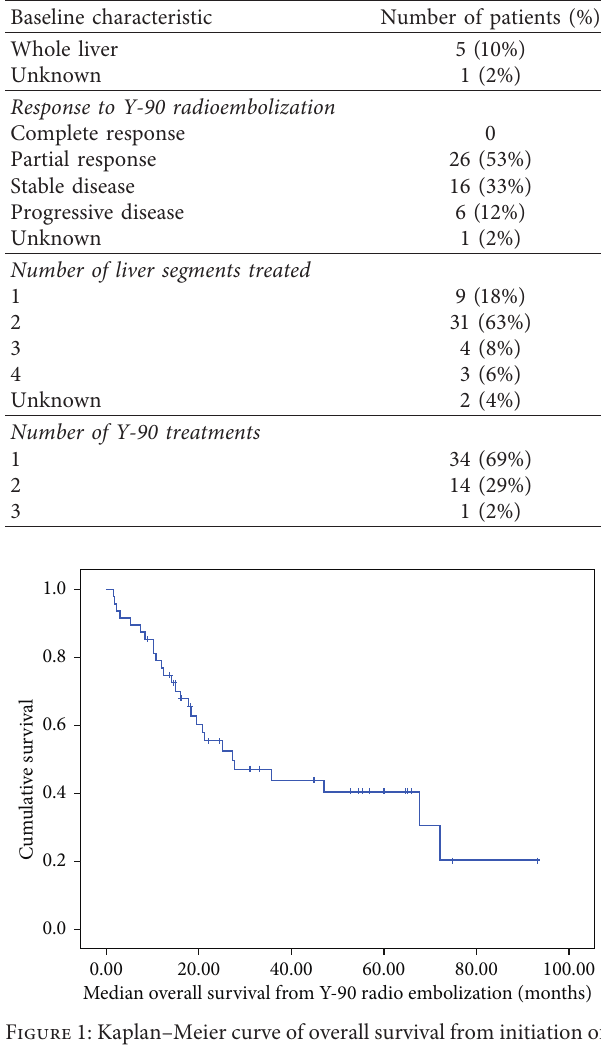
Table 1: Baseline demographic and clinicopathologic character- istics of patients with metastatic liver-dominant NETs who received